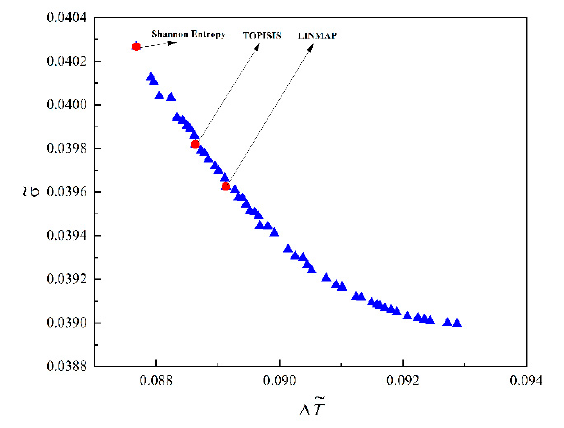
Figure 6. Pareto frontiers of ∆ (cid:101) T and (cid:101) σ with MOO under three-DOF optimization.